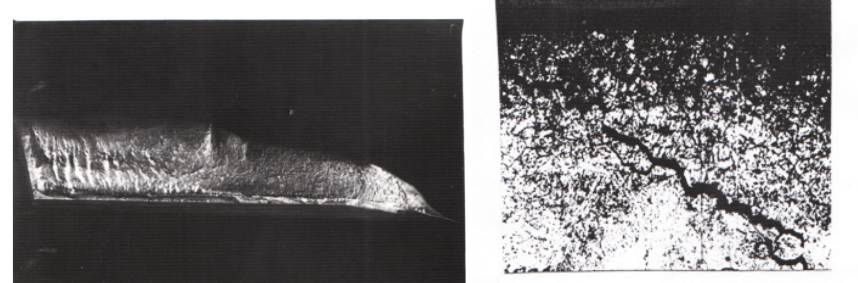
Figure 8: Surface of failure (sample 3) and sample